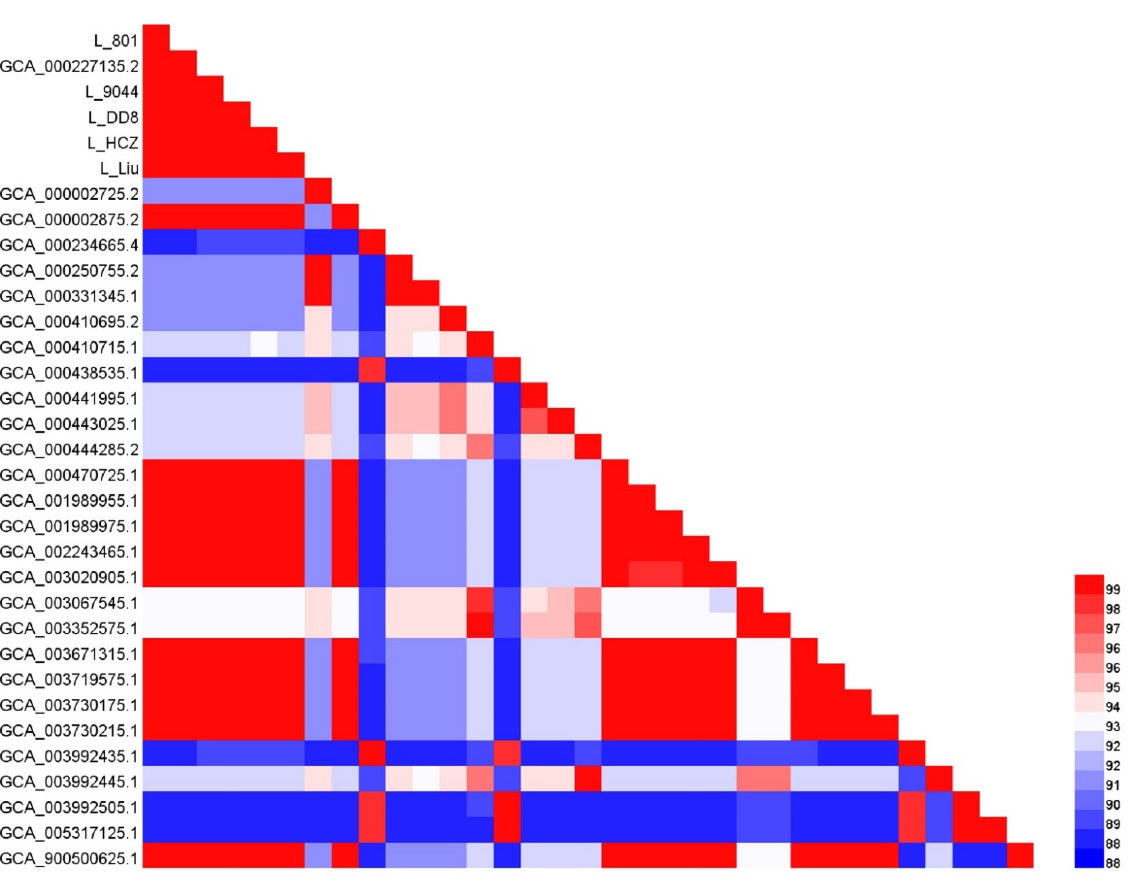
Figure 5. Whole-genome average nucleotide identity matrix of the 33 Leishmania strains. The heatmap was generated by the software HemI (Heatmap Illustrator, version 1.0.3.7) and shows the similarity value of genomic nucleic acids in pairwise comparison. Red represents the high similarity value of genomic nucleic acids, and blue represents the low similarity value of genomic nucleic acids.